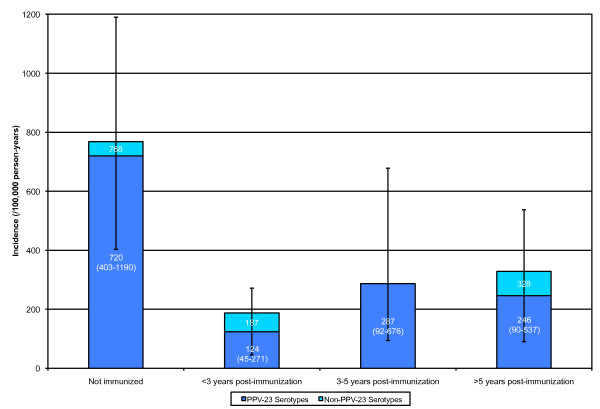
Incidence of IPD with immunization. Crude incidences with 95% Poisson confidence intervals are shown for PPV-23 serotypes. The incidence of IPD within three years of immunization was significantly lower than the incidence before immunization (P < 0.001). A composite incidence >3 years post-immunization incidence (not shown; mean: 262, 95% CI: 131-469) was also significantly lower than incidence before immunization (P < 0.01).